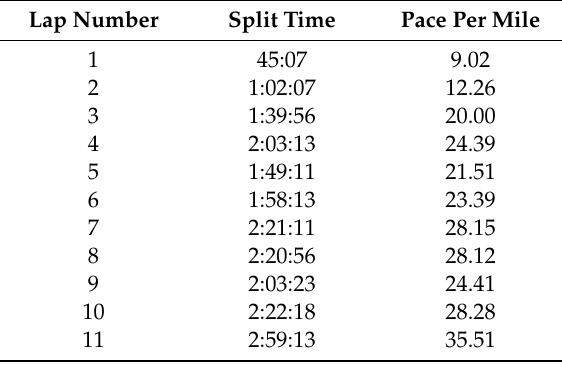
Table 1. Participant splits and pace per lap over the duration of the obstacle course race